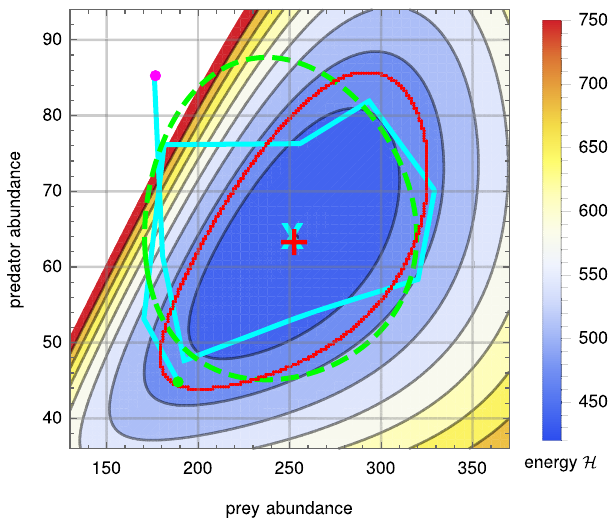
Fig. 5 | An application to a predator – prey system demonstrates the ability of DFTe to capture non-equilibrium steady-state dynamics. The DFTe hypersur- face H ð N Þ is a platform for ecosystem dynamics, much like the analogous energy surface of classical physics is for Kepler orbits in a gravitational fi eld. The cyclic DFTeequipotentialline(redcurve)probes H awayfromequilibrium(redplussign) and captures the empirically measured cycle (cyan curve, starting at the magenta dot and ending at the green dot) centred on the cyan cross, which represents the average measured abundances and anchors the DFTe fi t. Strong excitations on H permit predator extinction along noncyclic trajectories: the high-energy equipo- tentiallinesterminateattheabscissa,butnotattheordinate( H exceeds750inthe whiteregionanddivergestowardstheordinate;seealsoSupplementaryFig.8bfor anoverviewplotof H ).TheDFTetrajectorylacksinformationonthetime-resolved rates of abundance changes and, thus, does not translate unambiguously into a timeseriesthatwouldallowpoint-wisecomparisonwithpredictionsfromdynamic models — see Supplementary Notes for ways to augment DFTe with explicit Newtonian-type time evolution based on H . However, we compute the DFTe tra- jectoryby fi ttingonlythreeparametersand fi ndittobeofsimilarqualitytoa fi tted trajectory from the standard six-parameter Lotka – Volterra model (dashed green; see Supplementary Notes), as judged by a LV = A LV = A exp (cid:3) 1 ≈ 49% and a DFTe = A DFTe = A exp (cid:3) 1 ≈ 51%, which quantify the excess of the areas A LV and A DFTe , enclosed by the corresponding predicted trajectories, over A exp , enclosed by the experimental